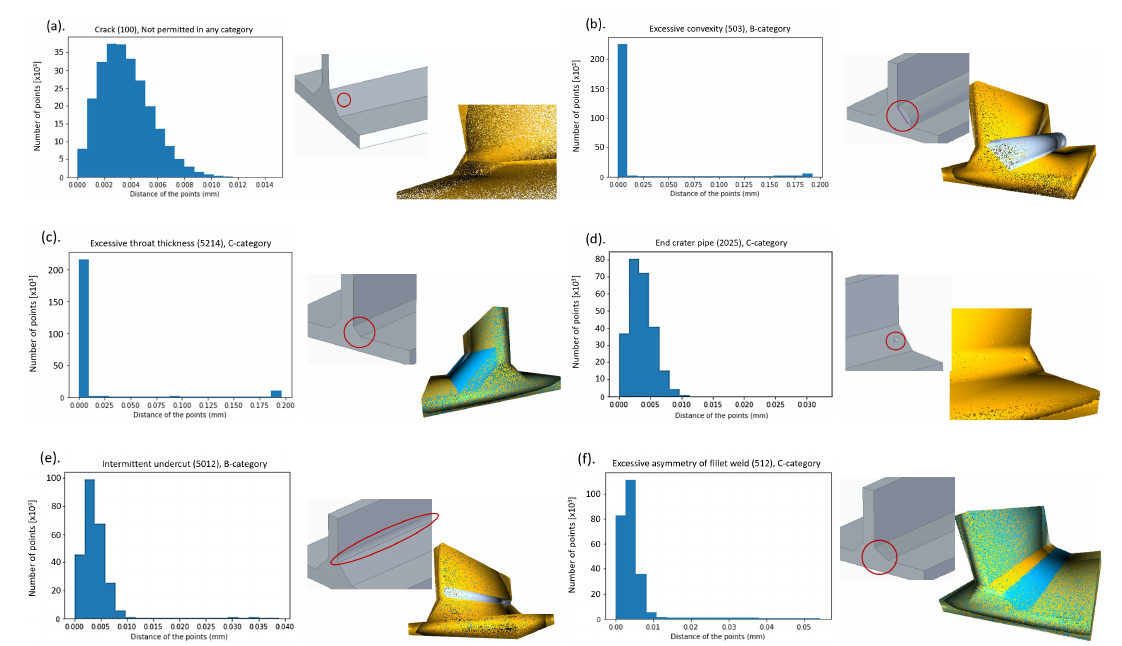
Figure 5. Exemplary distributions—CAD models of welding deviations.